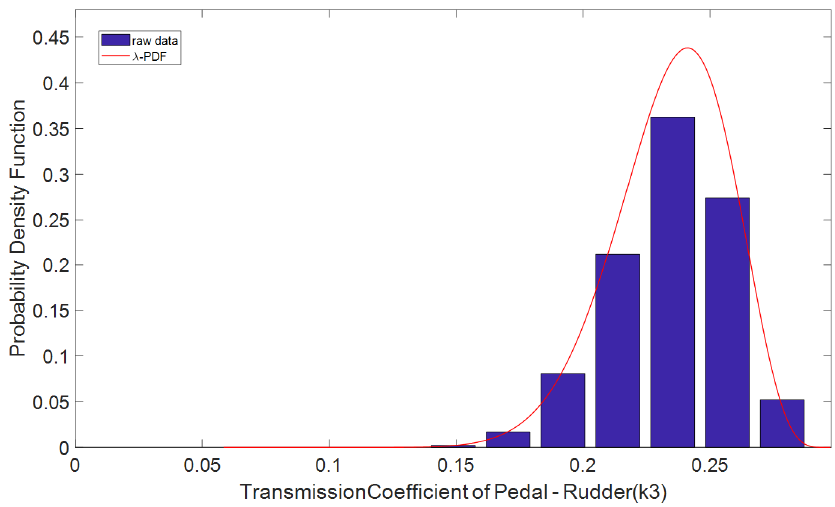
Figure 7. PDF of transmission coefficients from pedal to rudder.